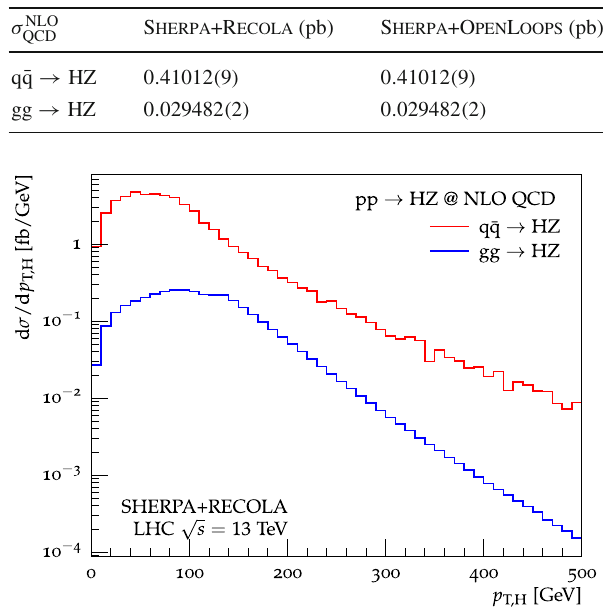
Fig. 4 The transverse-momentum distribution ofthe reconstructed b ¯ b- decayed H boson in the pp → HZ process at NLO QCD